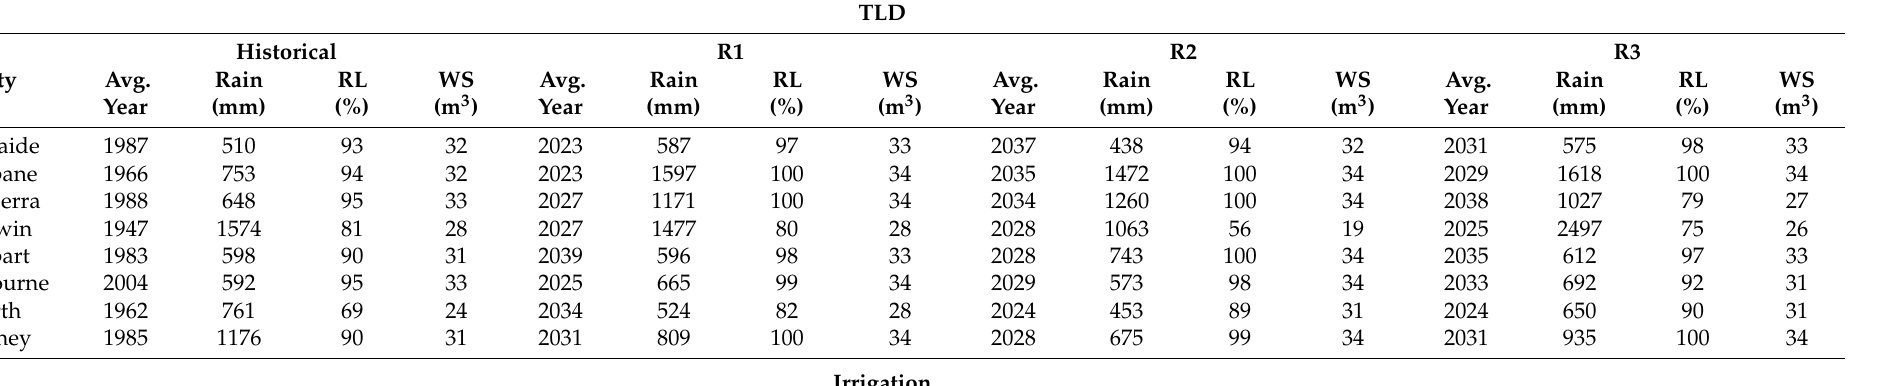
Table 3. Summary of average year rainfall, reliability and water savings for all the eight cities for both the historical and future period (TLD and irrigation use).